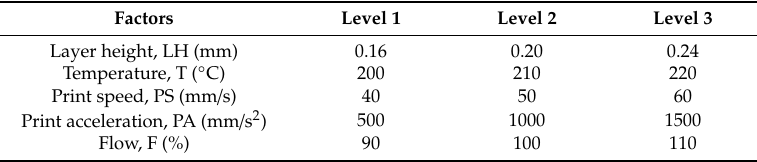
Table 2. Factors and levels used in the design of experiments (DOE).